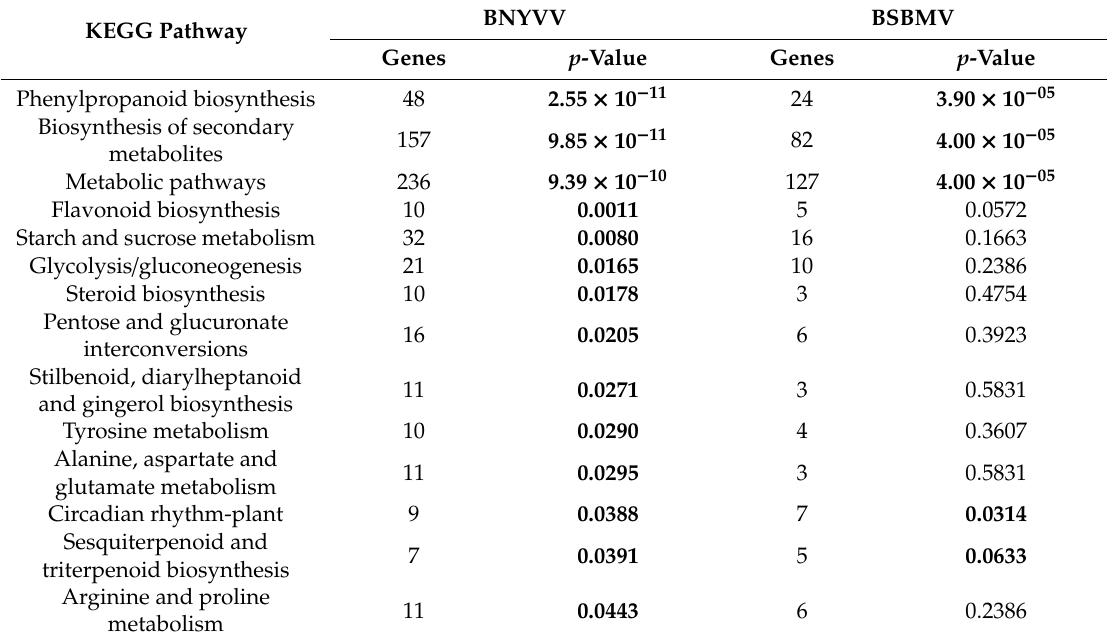
Table 3. Significantly enriched KEGG pathways identified in BNYVV- and BSBMV-infected plants. p -Values lower than 0.05 are highlighted in bold